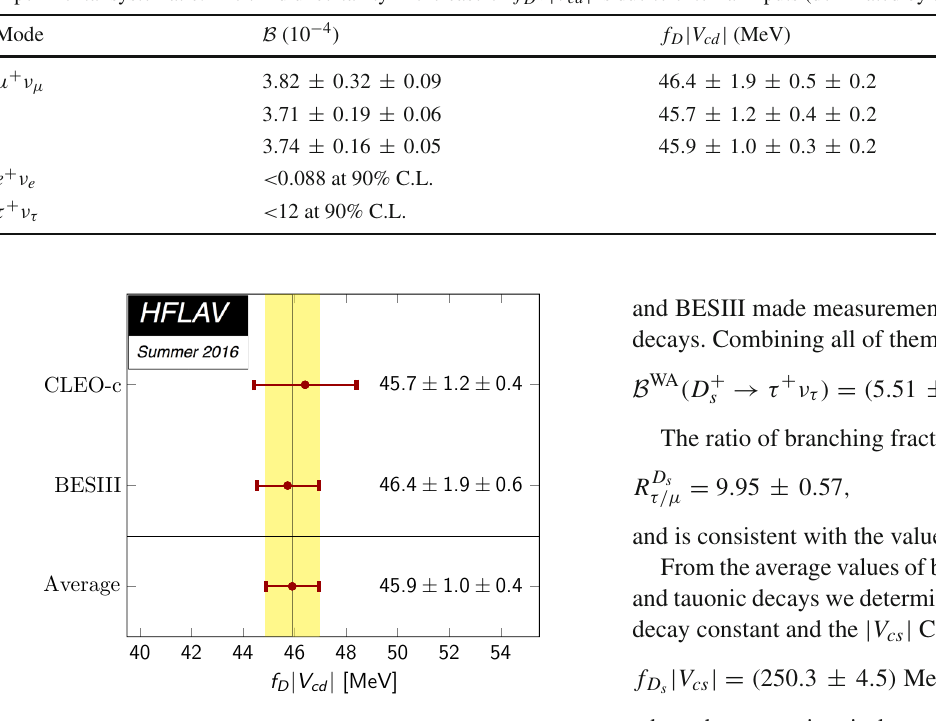
where the uncertainties are from the experiments and lattice calculations, respectively. All input values and the resulting world averages are summarized in Table 282 and plotted in Fig.